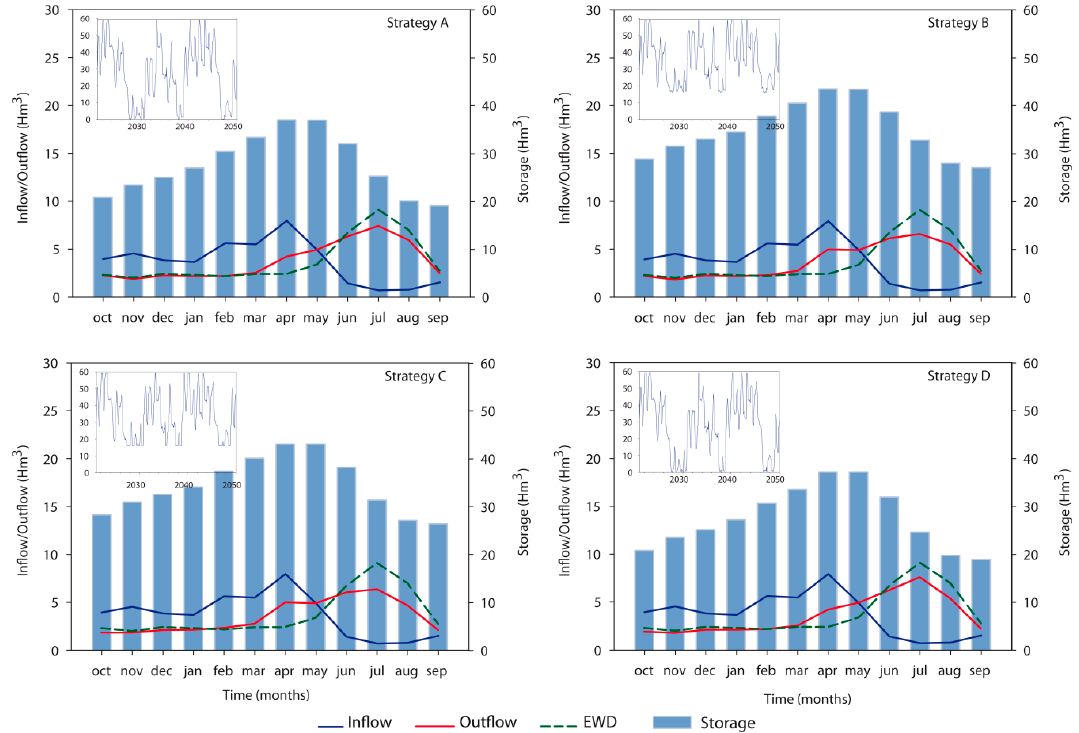
Figure 13. Monthly mean reservoir storage for the simulation period 2021–2050: four experiments (management strategies) in the Boadella–Darnius dam ( A ) maintaining the outflow to satisfy EWD without limitations in water storage, ( B ) maintaining the outflow to satisfy EWD avoiding the reservoir depletion, ( C ) maintaining the outflow to satisfy WD, avoiding the reservoir depletion, and ( D ) maintaining the outflow to satisfy WD without limitations in water storage.